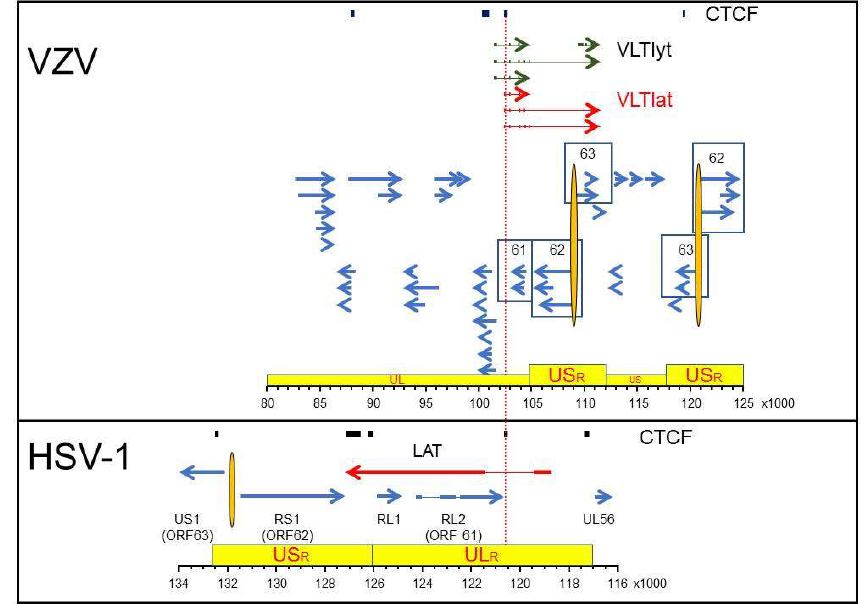
Figure 1. Latency associated transcription regions of VZV and HSV-1. The regions of VZV (top panel) and HSV-1 (bottom panel) that span predicted (VZV) or discovered (HSV-1) CTCF-binding sites are shown relative to the most current VZV transcription annotation (Braspenning et al. 2020) and the annotated HSV-1 reference sequence (NCBI Reference Sequence: NC_001806.2). The genomes are presented with the latency associated transcripts on the top strand in 5’ to 3’ orientation. Arrows show the relative size and direction of each transcript with exons (thick arrows/lines) and introns (thin lines). The red colored latency associated transcripts are distinguished from the blue lytic gene transcripts with the VZV Varicella Latency Transcripts associated with initial stage of virus reactivation colored green (VLTlyt). Specific genes mentioned in the text are identified by number (VZV) or name (HSV-1) with variants of associated genes contained within boxes. The topological architecture of each genome is shown in yellow boxes with the unique long (UL), unique short (US) and associated repeat regions (ULR, USR) highlighted. The nucleotide position of the selected DNA regions is listed for each virus in the ruler at the bottom of each box.